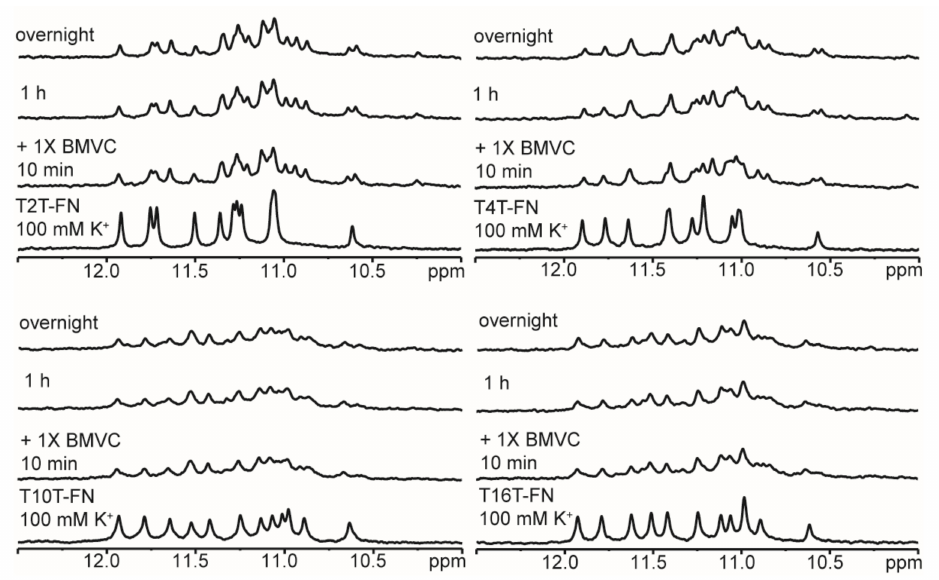
Figure 9. Ligand binding of BMVC to (G 3 TG 3 N m G 3 TG 3 )-FN G4 structures. Imino proton NMR spectra of T2T-FN, T4T-FN, T10T-FN, and T16T-FN in 100 mM K + solution and after 10 min, 1 h, and overnight addition of 1 eq.